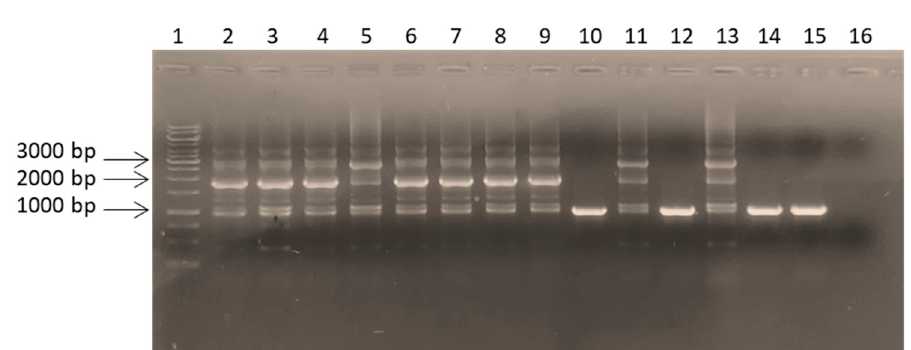
Figure 2. PCR amplicons, obtained using coli_hisF_ext FW and coli_hisF_ext REV primers, of some His + revertants obtained from the CFGE experiments. Lanes: (1) GeneRuler 1 kb DNA ladder (ThermoFisher Scientific, Waltham, MA, USA); (2–15) hisF amplicons from fourteen HisF +